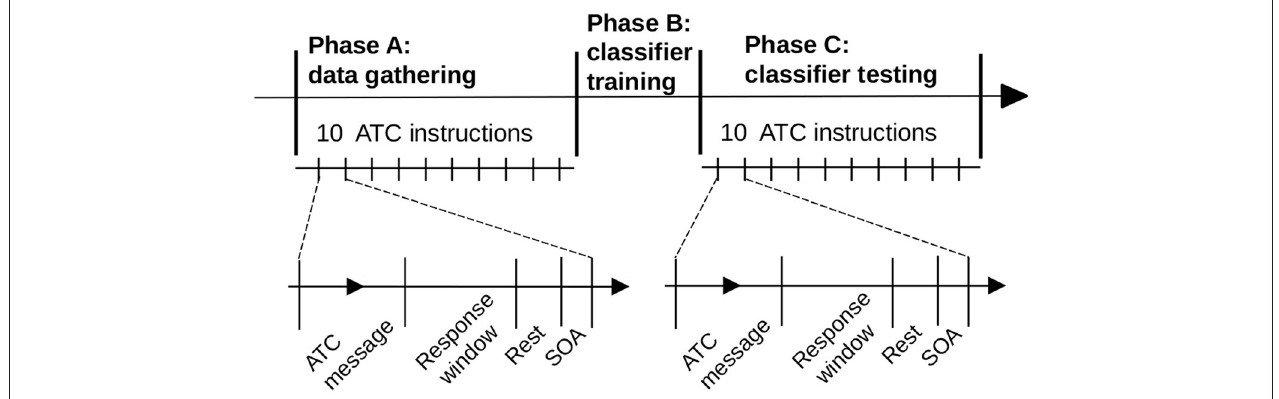
FIGURE 4 | The experiment was split into three successive phases. Data gathering ( phase A ) and classifier testing ( phase C ) consisted of 10 ATC instructions each. The pilot’s classifier was trained between these two phases ( phase B ). The time scale of the figure is